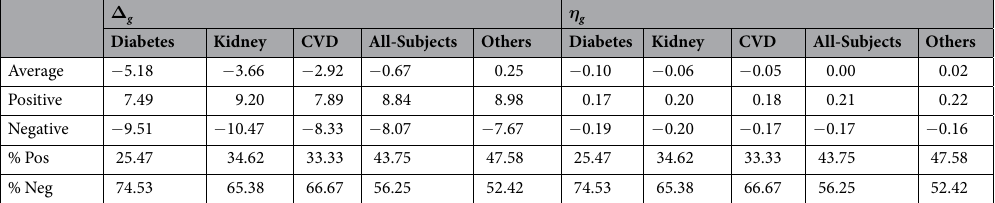
Table 9. Performance of estimated biological age of subjects having different chronic diseases.